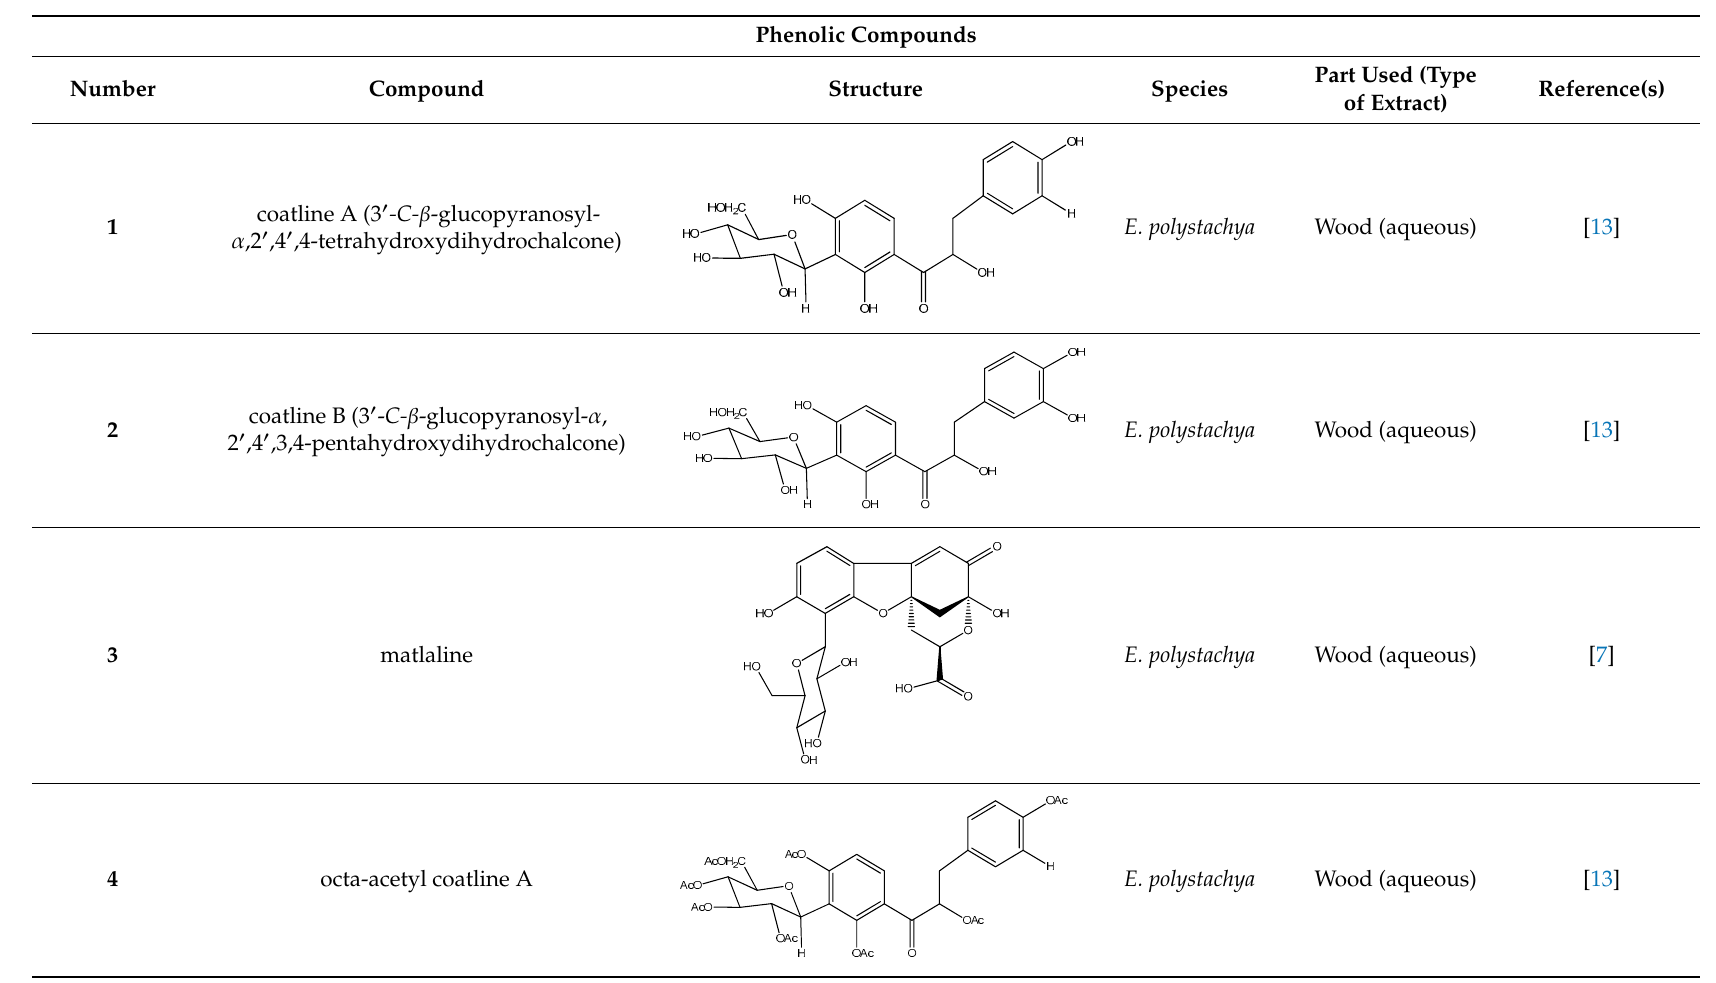
Table 1. Phytochemical compounds identified in the species Eysenhardtia